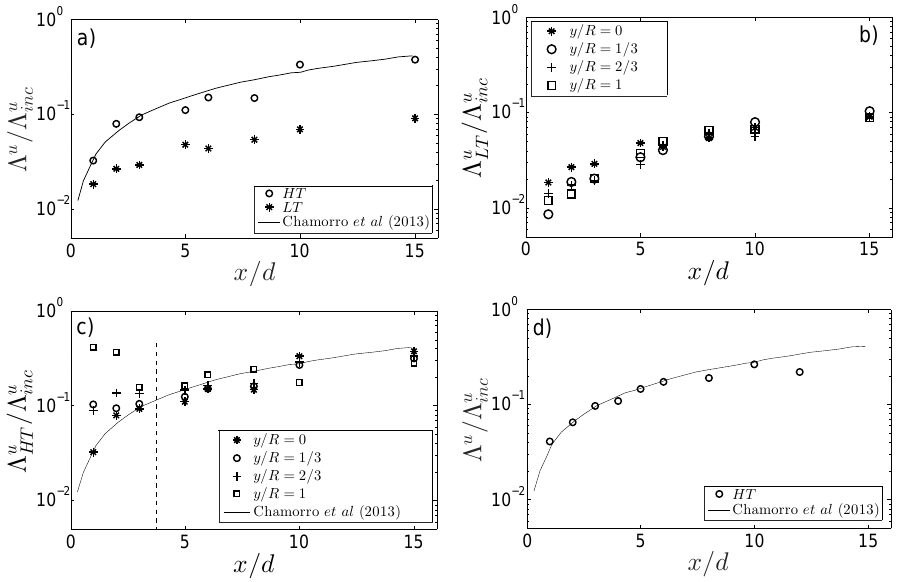
Figure 7. Normalized integral length scale. ( a ) At y / R = 0; ( b ) LT case; ( c ) HT case; ( d ) HT case with fixed measurement location (hotwire). Results from Chamorro et al. [17] are included as a reference.